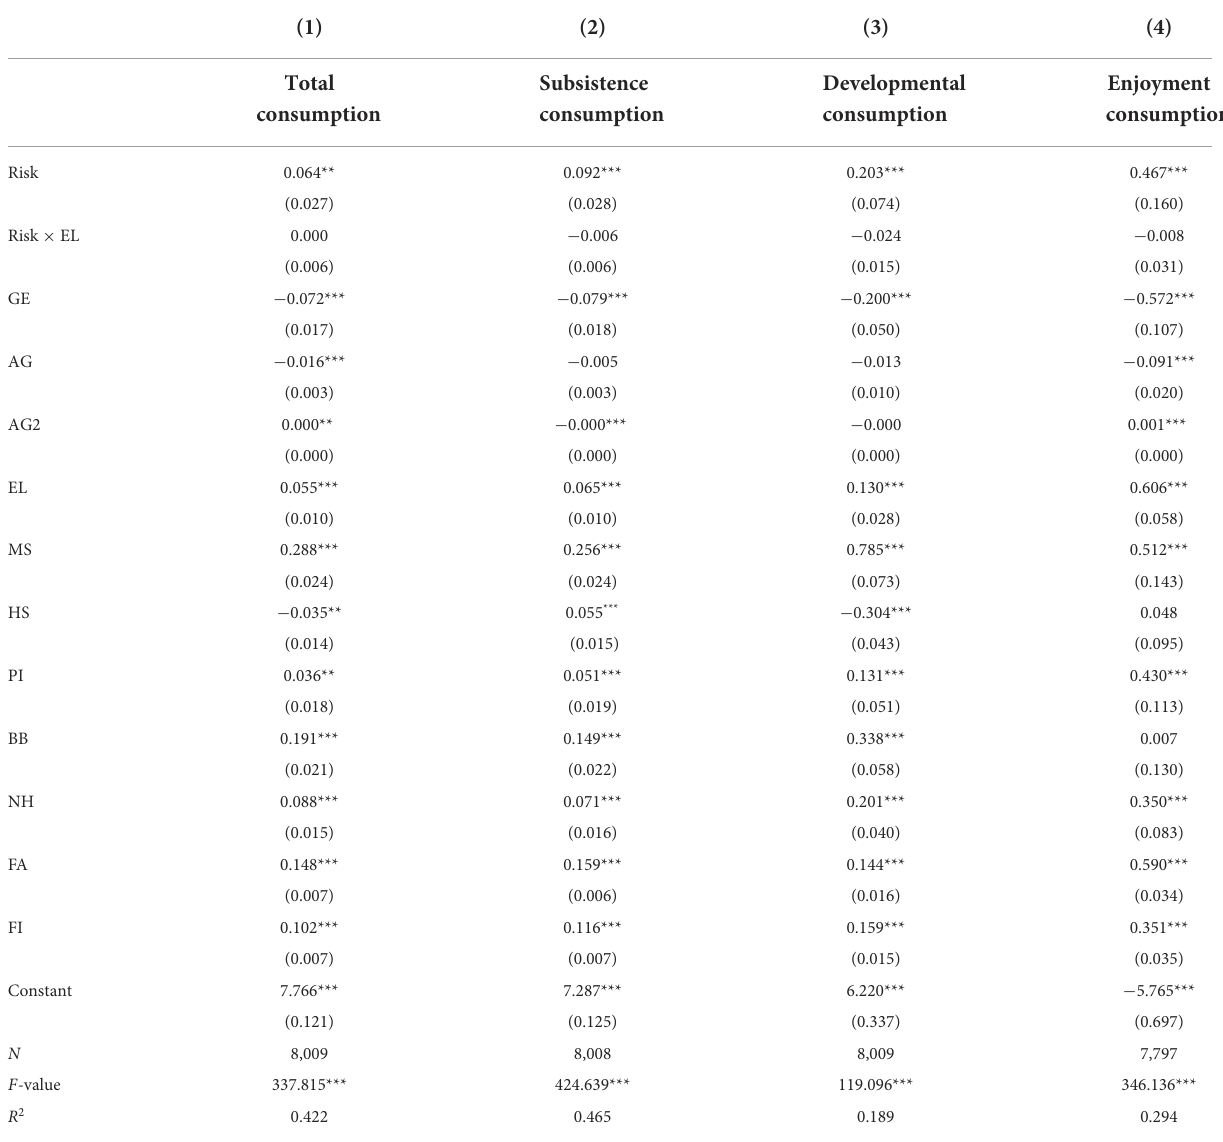
TABLE 9 Results of education level heterogeneity